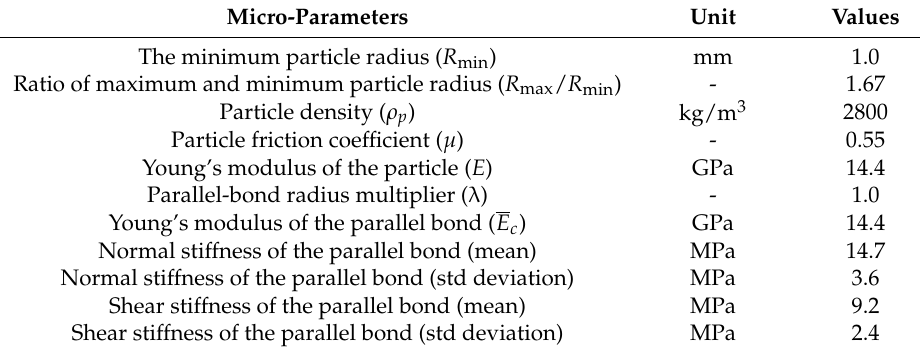
Table 1. Micro-properties used in intact rock for simulated specimens after calibration [41] .